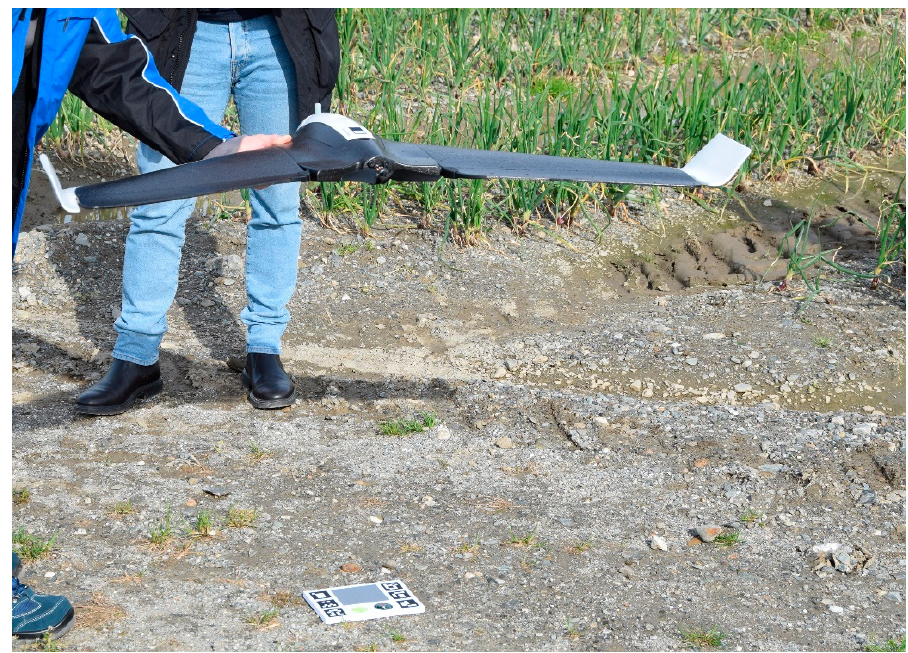
Figure 3. The Parrot Disco-Pro AG fixed-wing unmanned aerial vehicle (UAV) during the pre-flight calibration using the Parrot Sequoia calibration target.